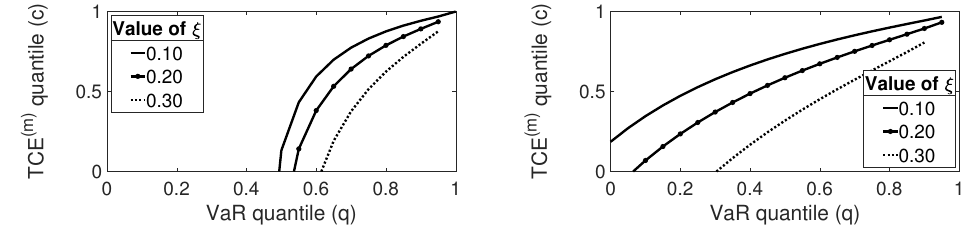
Figure 4. Extended TCE quantile as a function of VaR quantile. ( Left panel ): m = 2, σ = 0.1, and µ = − 0.05. ( Right panel ): m = 2, σ = 0.1, and µ = +